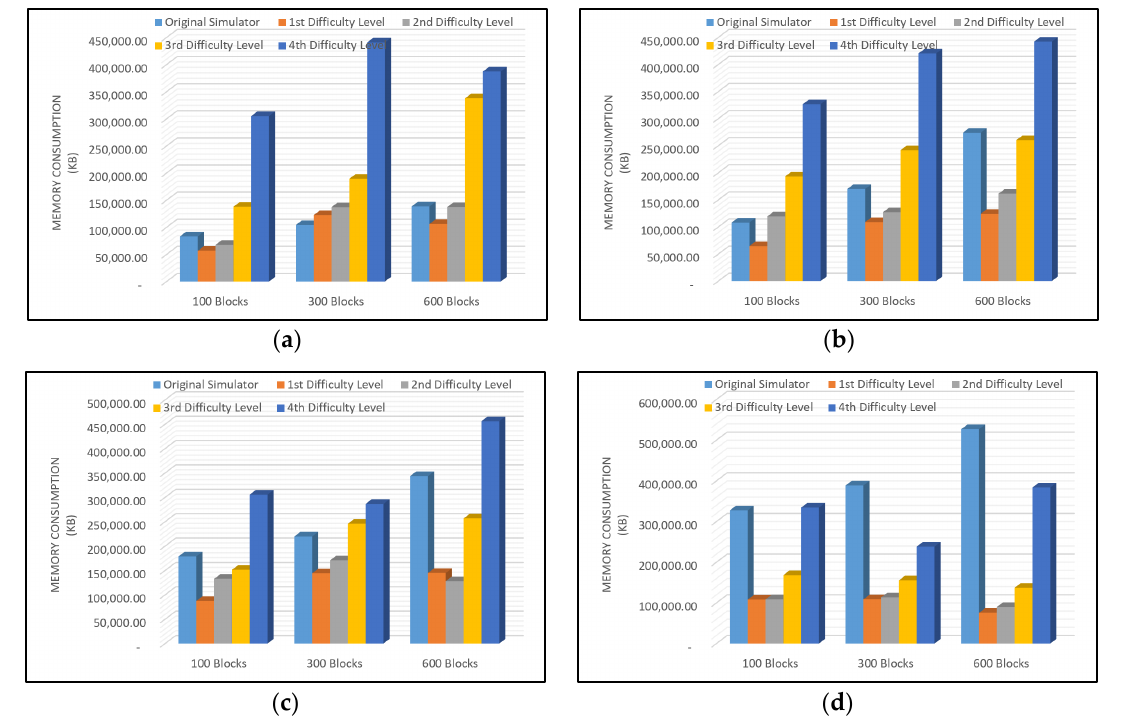
Figure 11. Memory Consumption Rate ( a ) 100 Nodes; ( b ) 300 Nodes; ( c ) 600 Nodes; ( d ) 1000 Nodes.